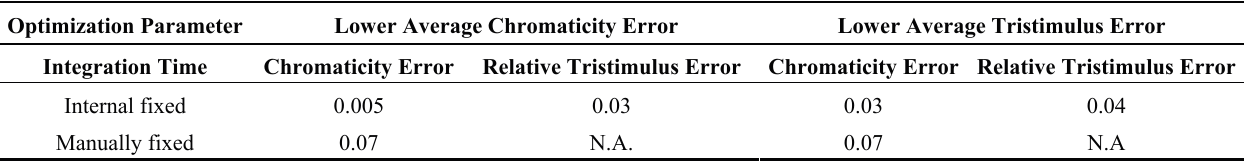
Table 1. Average chromaticity and tristimulus error obtained by two optimization